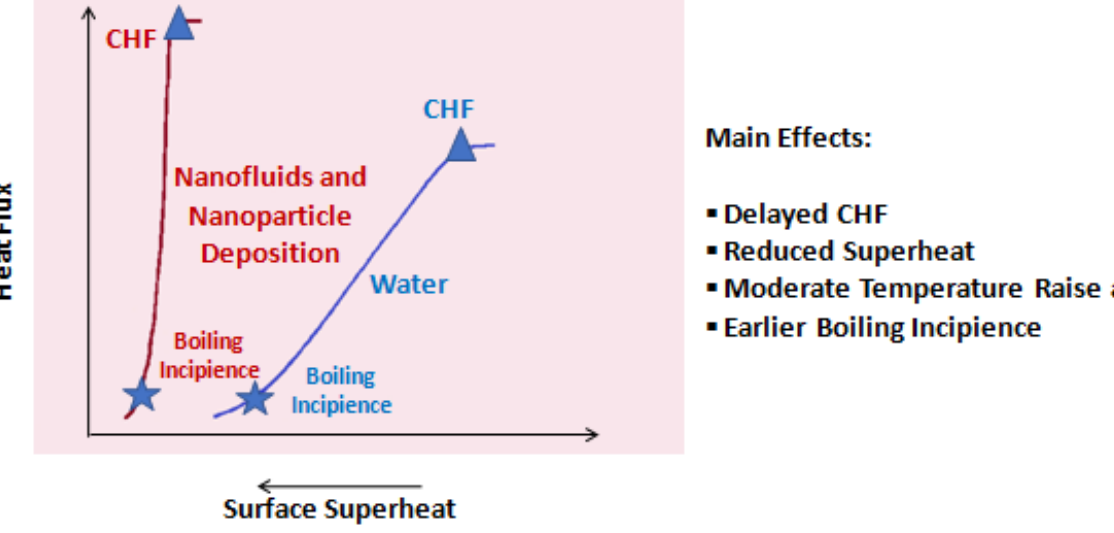
Figure 3. Positive effects of the nanofluids and nanoparticle deposition relative to water. Adapted from [47].